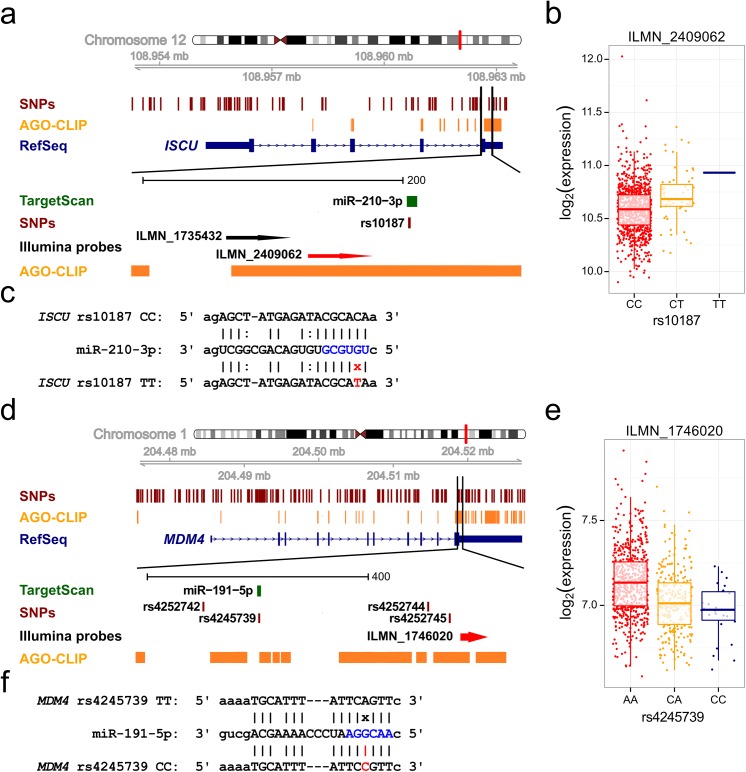
MRE-SNPs in the ISCU and MDM4 genes.(a), (d) A schematic depiction of each gene locus. Tracks denote the genomic region, SNP positions, AGO binding sites from starBase, most prevalent RefSeq transcript isoform, miRNA target sites from TargetScan v6.2, and Illumina detection probes. The region with the cis-eQTL MRE-SNP and affected probe (marked red) is expanded. (b), (e) Allelic expression pattern in the EGCUT sample set. Log-transformed and quantile-normalized expression values are visualized as boxplots, and individual expression values are depicted as points. On the boxplots, the line indicates median, box defines 25% - 75% quartiles and whiskers extend the data to 1.5× of interquartile range. (c), (f) MRE-SNP effects on miRNA binding. Vertical lines indicate canonical pairing, colons depict G:U wobble, and "x" denotes a mismatch. The miRNA seed region is shown in blue, and the MRE-SNP minor allele and its effect on miRNA binding is shown in red.